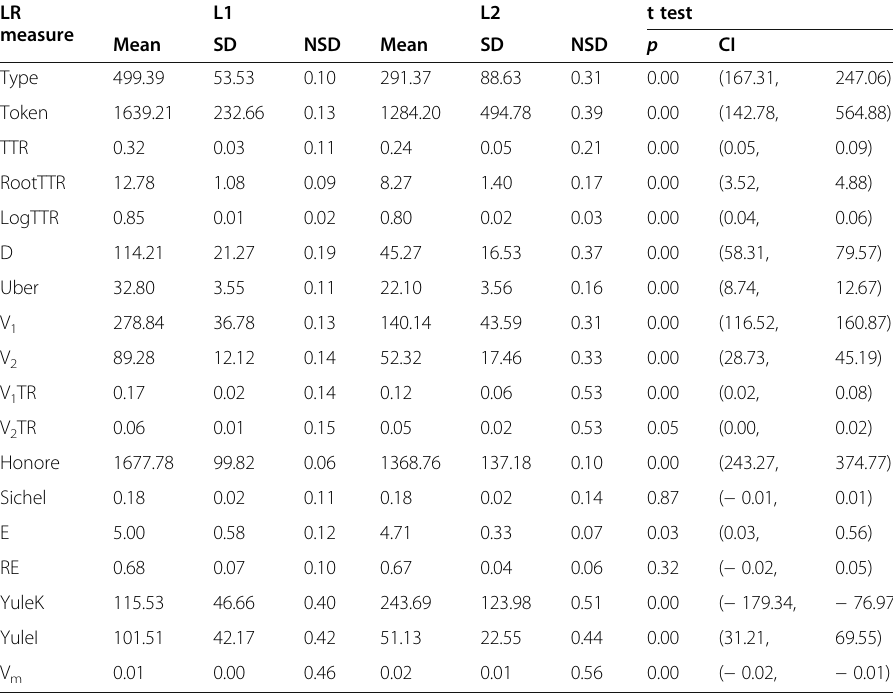
Table 4 ANOVA statistics for comparison of LR difference by words in L1 and